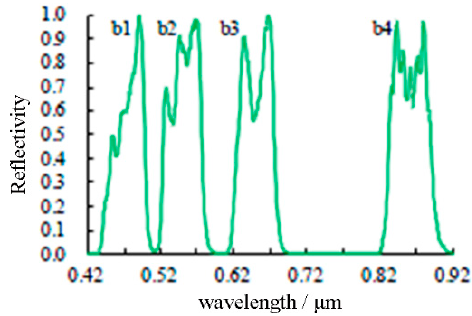
Figure 2. The spectral response function of the FengYun-3C (FY-3C) MERSI data.